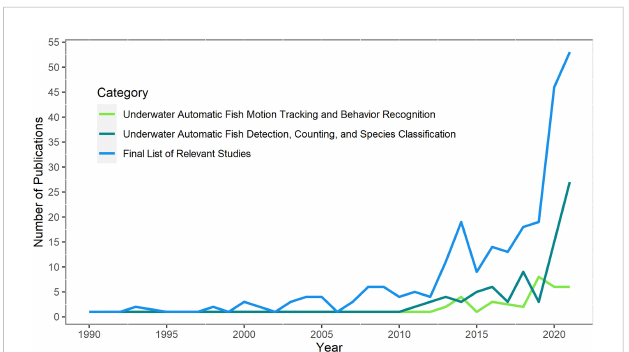
FIGURE 2 Number of publications between 1989 and 2022 for the 3 categories.